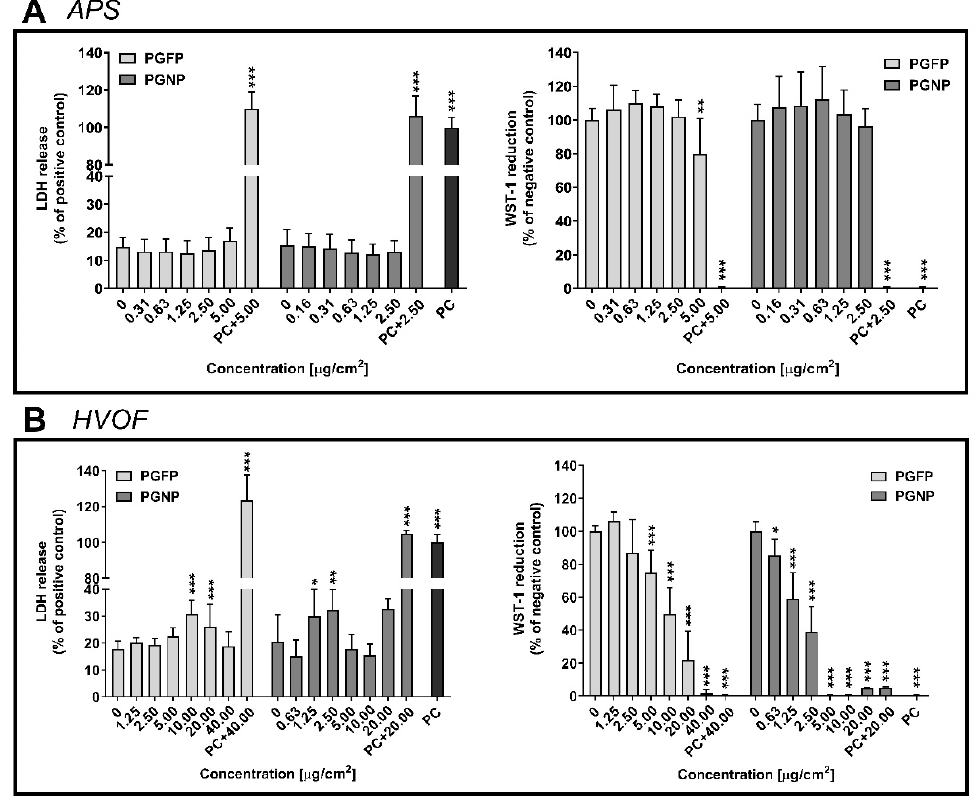
Figure 1. Cytotoxicity of PGFP and PGNP released during APS ( A ) and HVOF ( B ) in human alveolar epithelial cells after 24 h of exposure. Data are expressed as means ± standard deviations (n = 3–4). LDH release values were normalised considering the positive control (total LDH release; cells lysed with 2% Triton X-100), while WST-1 reduction values were normalised considering the negative control (NC). Data were analysed by the one-way analysis of variance (ANOVA) test followed by Dunnett’s post hoc test for multiple comparisons. * p ≤ 0.05, ** p ≤ 0.01 and *** p ≤ 0.001 vs. NC. PC: Positive control (LDH: 2% Triton X-100; WST-1: 70% EtOH).